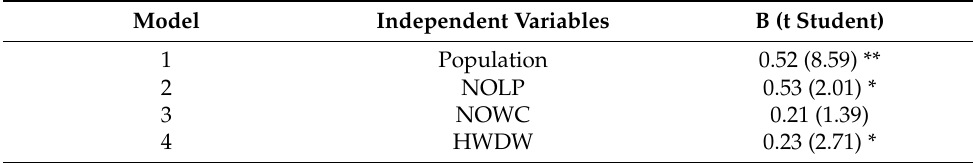
Table 5. Results of the Cobb-Douglas cost